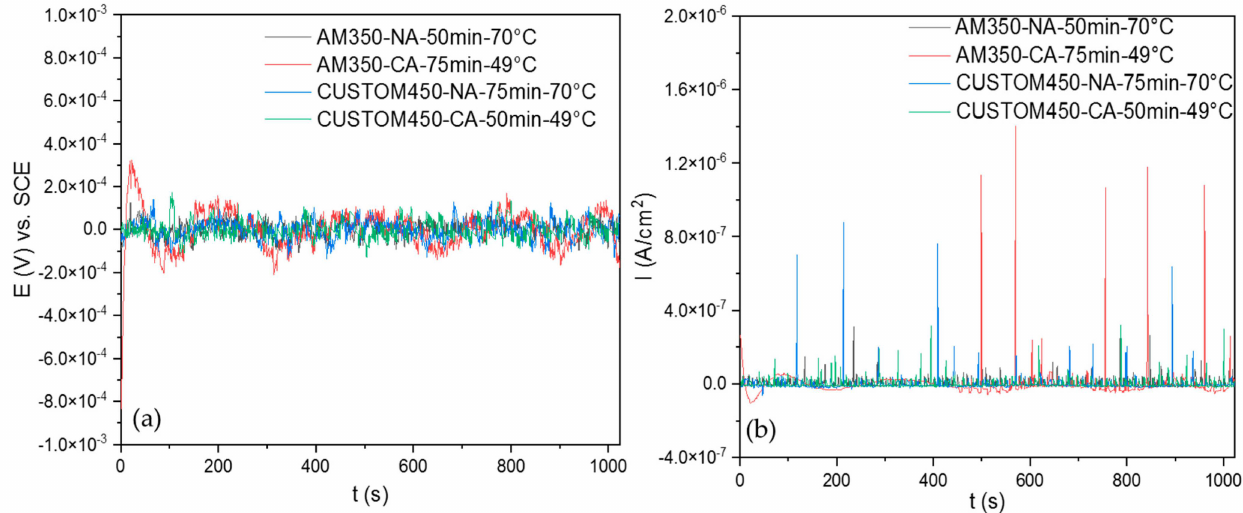
Figure 2. Electrochemical noise–time series: ( a ) EPN and ( b ) ECN, for CUSTOM 450 and AM 350 passivated stainless steels immersed in 1 wt. % H 2 SO 4